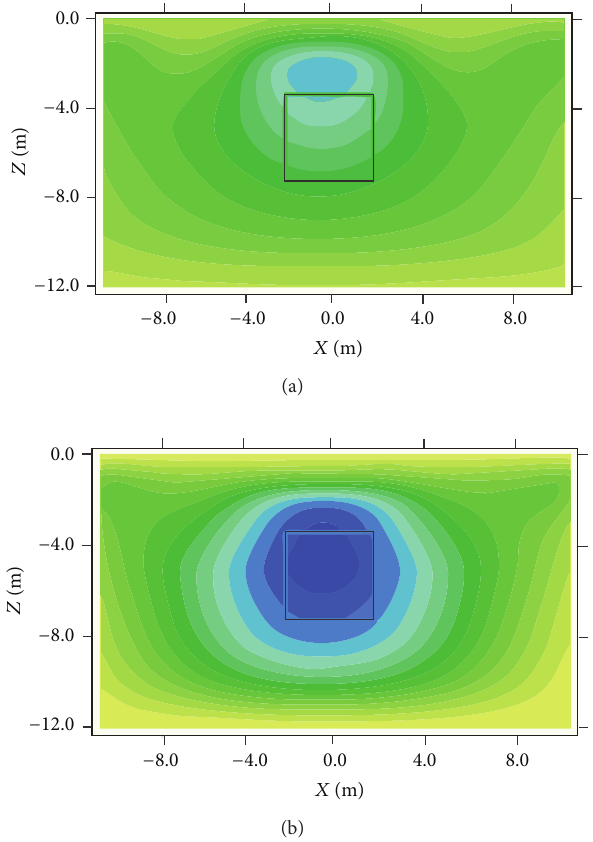
Figure 5: A comparison of inversion between original (a) and modified (b) sensitivity at section 𝑌 = 0